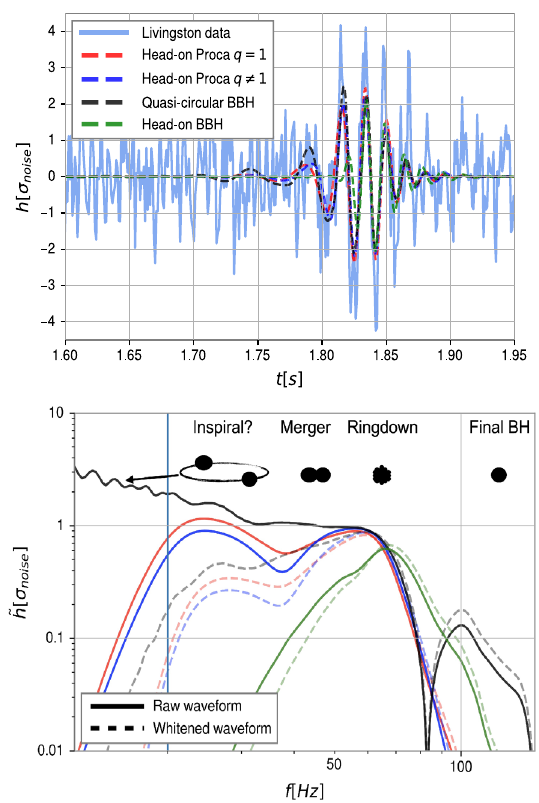
Fig. 32 Comparison of the predicted strains from a variety of compact object mergers (i.e, spinning Proca stars and black holes) with the GW190521 signal observed by LIGO Livingston. Top : Time domain comparison and Bottom : Frequency domain comparison. The equal mass ( q ¼ 1) and unequal mass ( q 6¼ 1) mergers of spinning Proca stars are remarkably faithful to the